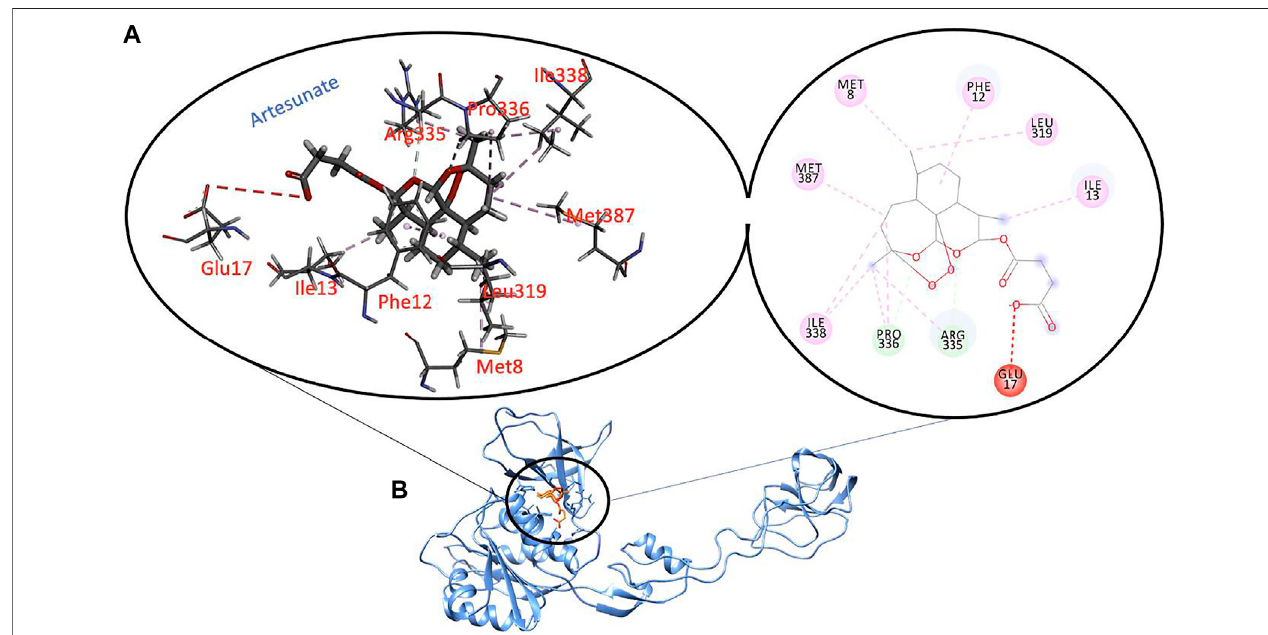
FIGURE 3 | Molecular interactions between key residues and reactive moieties in Gephyrin (A) . 3D structure of Artesunate in the active site of Gephyrin (B) .